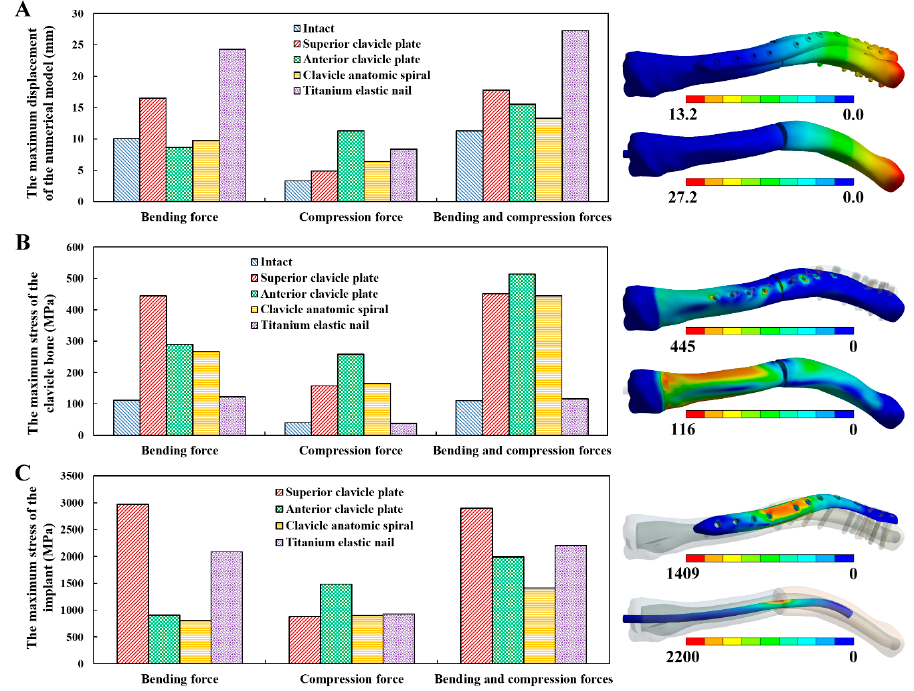
Figure 5. Results of the simplified models: ( A ) maximum displacement, ( B ) clavicle bone stress, and ( C ) implant stress.